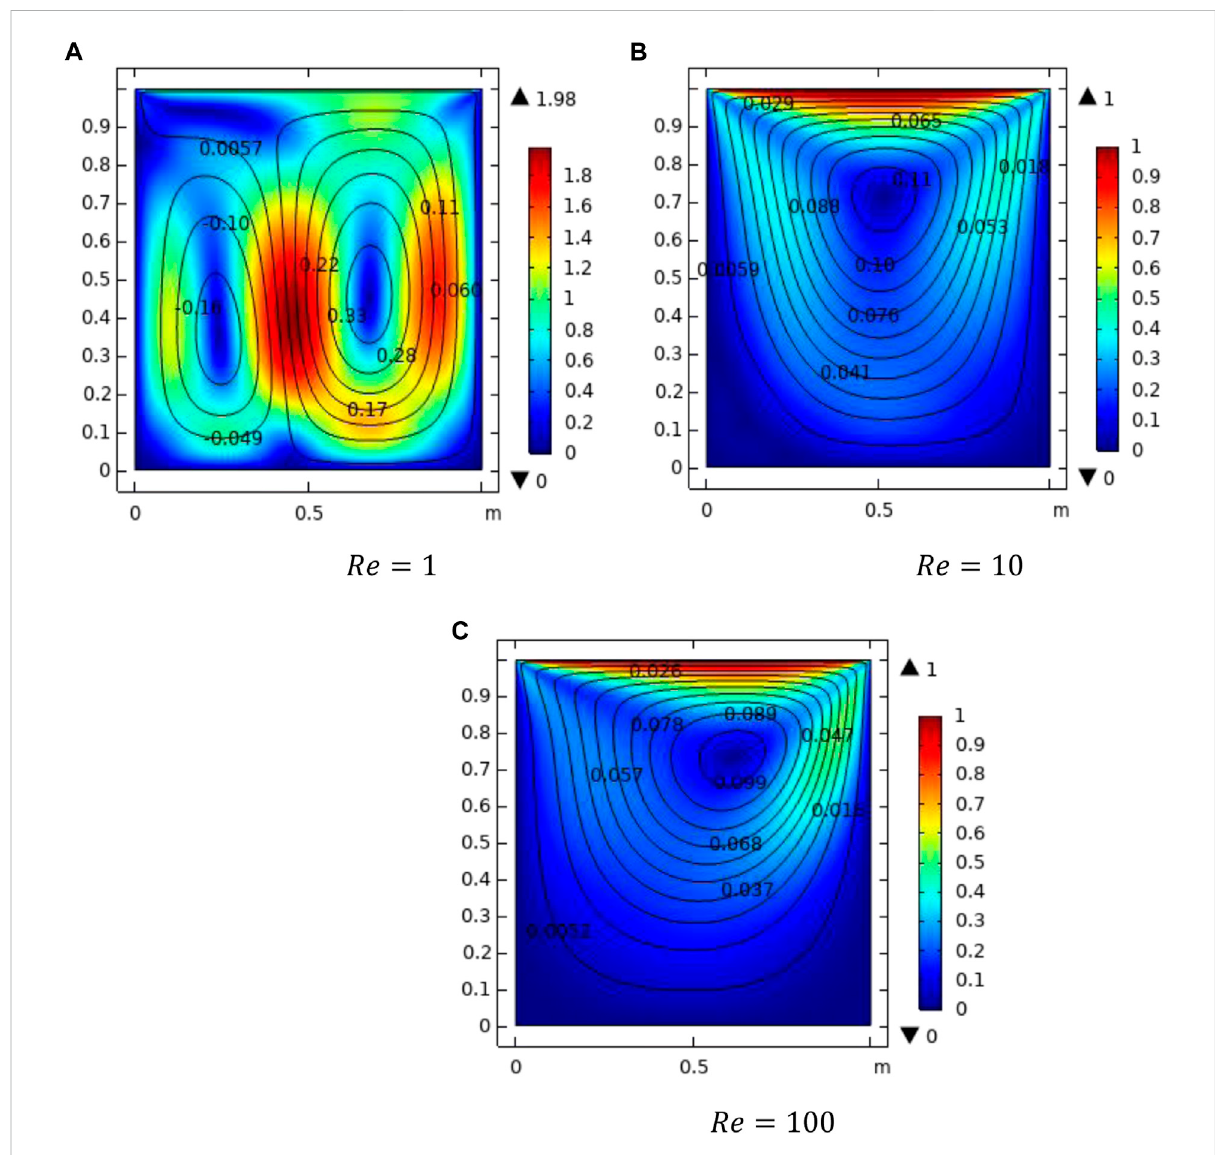
FIGURE 13 In fl uence of Re on streamlines for the non-uniform heating case: (A) Re (cid:1) 1, (B) Re (cid:1) 10, and (C) Re (cid:1) 100.